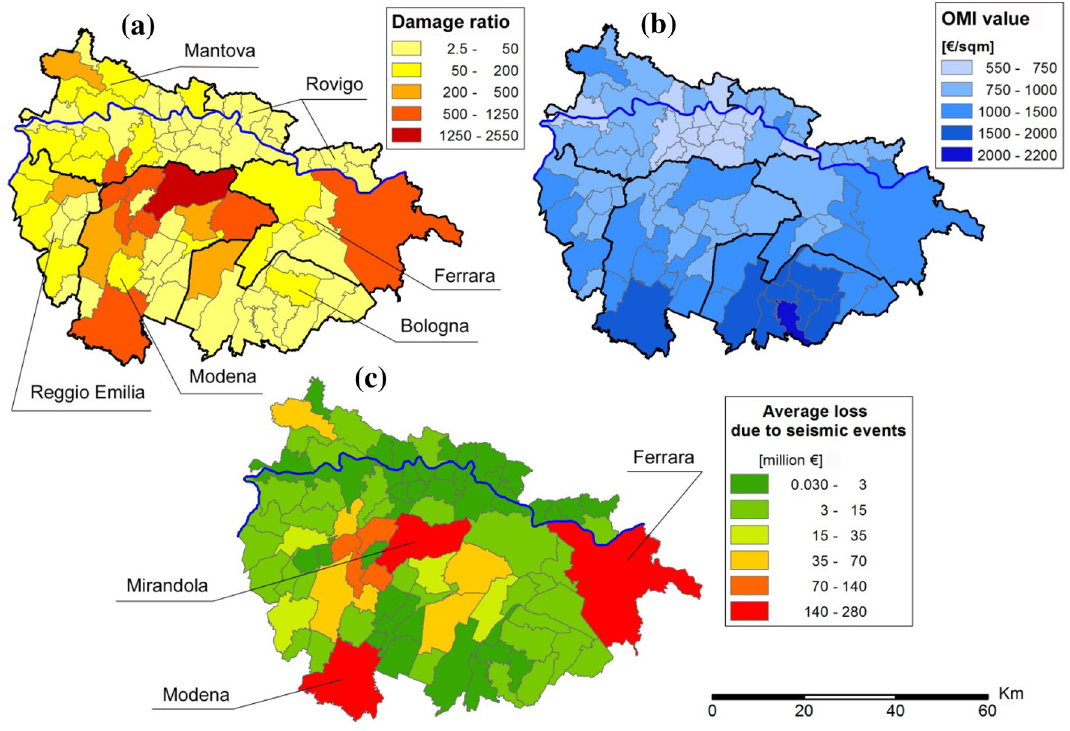
Fig. 5 Distribution of the features related to the economic loss assessment. a Distribution of damage ratio D R . b The average municipal OMI value. Darker lines represent the provincial areas. c The average loss for each municipality. The blue line represents the Po River